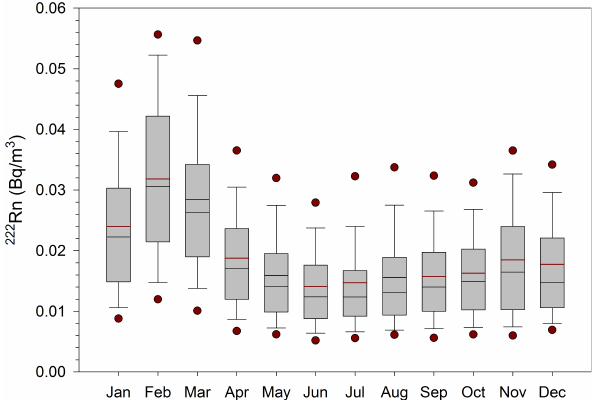
Fig. 4. Box plots for the mean seasonality of 222 Rn activity ob- served from 1995 to 2011. Lines in the middle of the boxes repre- sent sample medians (mean: red line), lower and upper lines of the boxes are the 25th and 75th percentiles; whiskers indicate the 10th and 90th percentiles, dots 5th and 95th